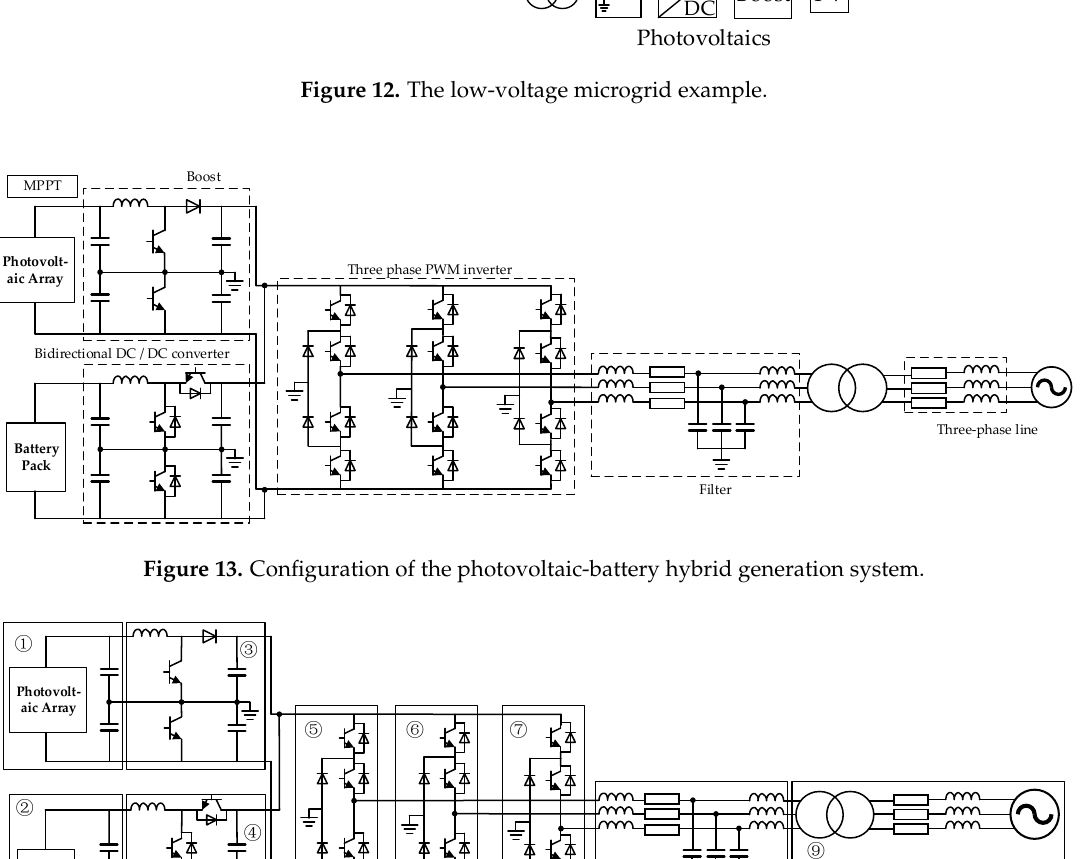
are selected as the independent input variables. Six node equations and four loop equations are written for the ten independent input variables, which can be obtained by solving the 10-dimensional network equations.